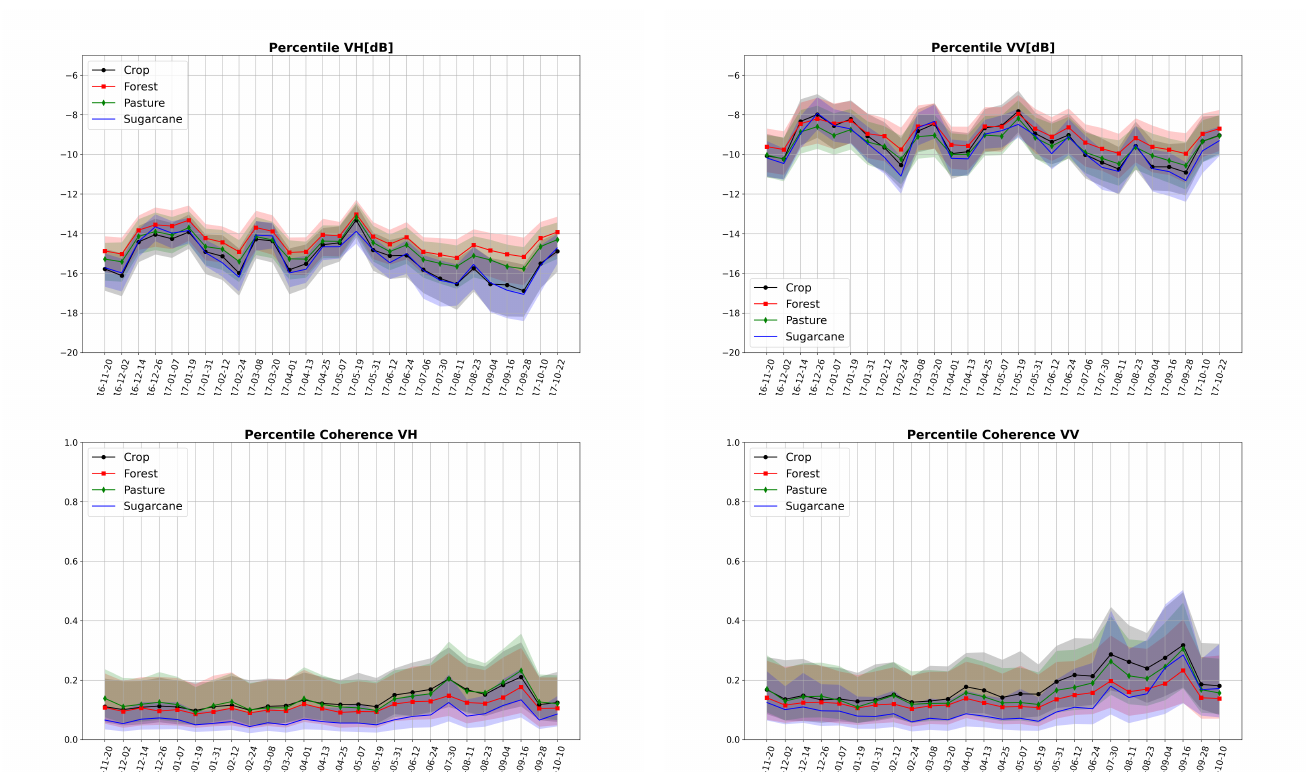
Figure 3. Temporal statistics of the backscatter intensity ( top ) and coherence ( bottom ) for the vegetation classes. The 50th percentiles (solid lines) and the 20th–80th percentiles (transparent buffer) are based on the features derived from the field sampling